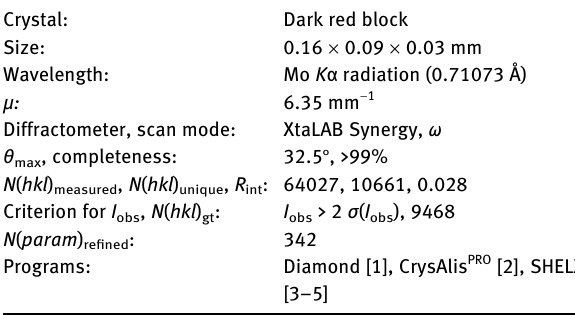
Table  : Data collection and